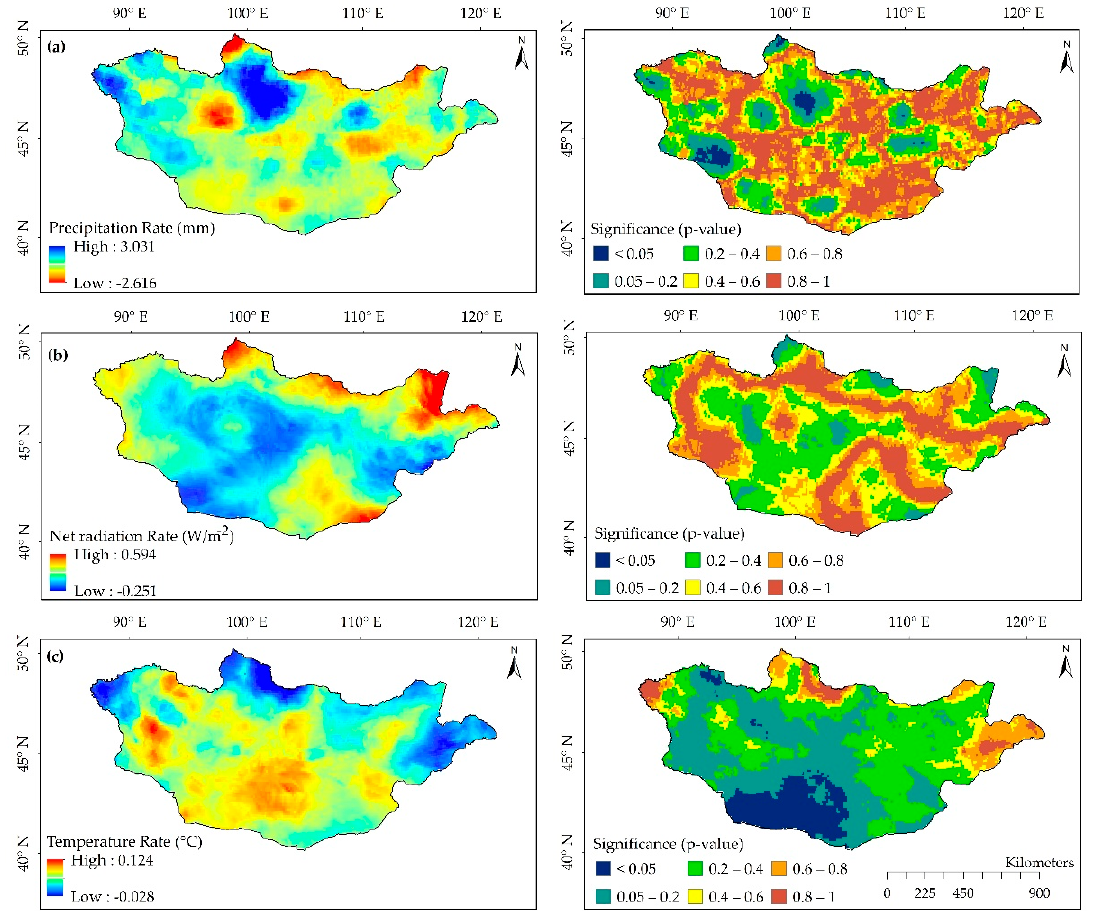
Figure A1. Trends of ( a ) temperature and its significance level ( p ‐ value); ( b ) precipitation and its significance level ( p ‐ value); and ( c ) net radiation and its significance level ( p ‐ value) from 2003 to 2018.